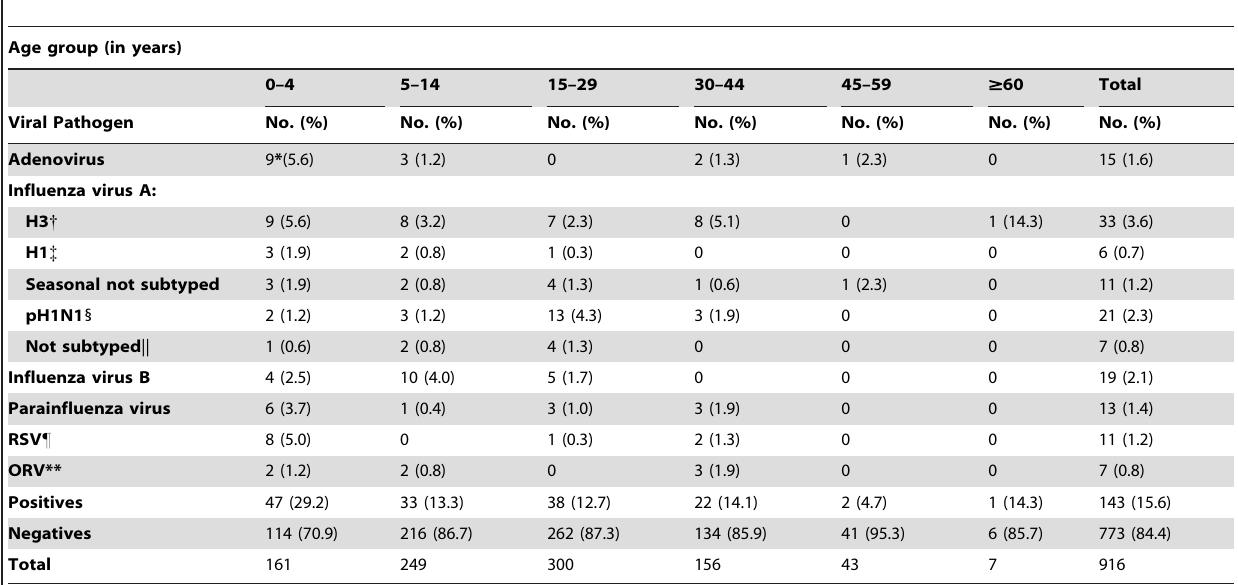
Table 2. Age distribution of febrile respiratory viral infections detected by passive surveillance in two Hospitals of Maracay, Venezuela: October 2006–December 2010.